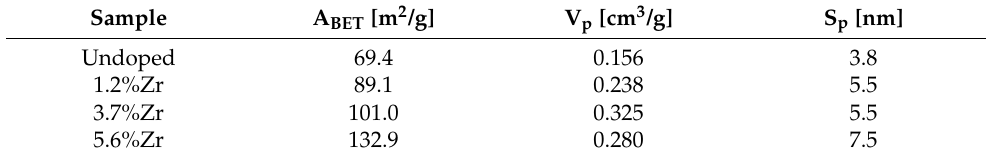
Figure 8. Nitrogen adsorption-desorption isotherm curves of nanopowders annealed at 450 ◦ C for 2 h. Table 5. Structural parameters of mesoporous TiO 2 nanopowders annealed at 450 °C for 2 h.